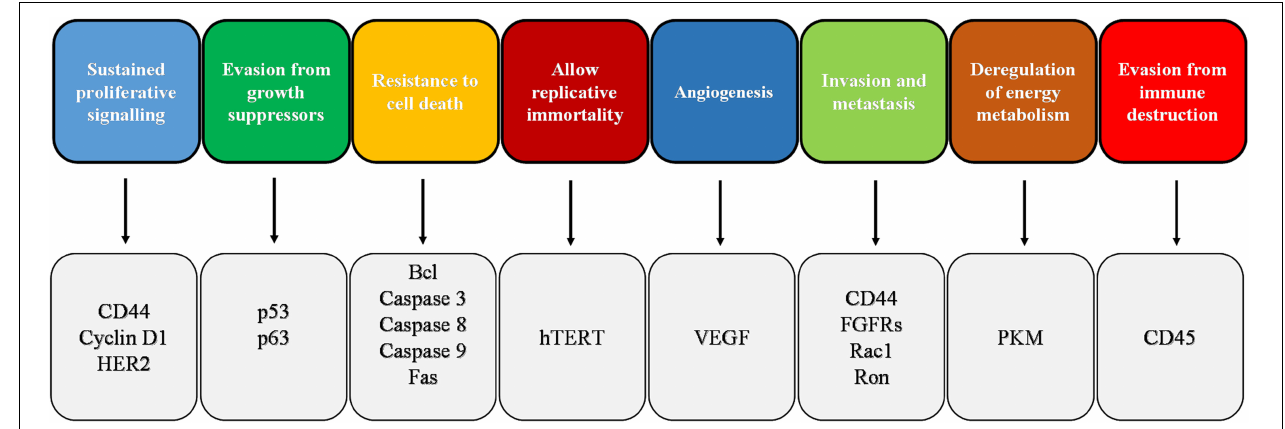
FIGURE 1 | Schematic representation of cancer hallmarks with the indication of the main markers involved in the corresponding hallmark. FGFR, fibroblast growth factor receptor; HER2, human epidermal growth factor receptor 2; PKM, pyruvate kinase M; VEGF, vascular endothelial growth